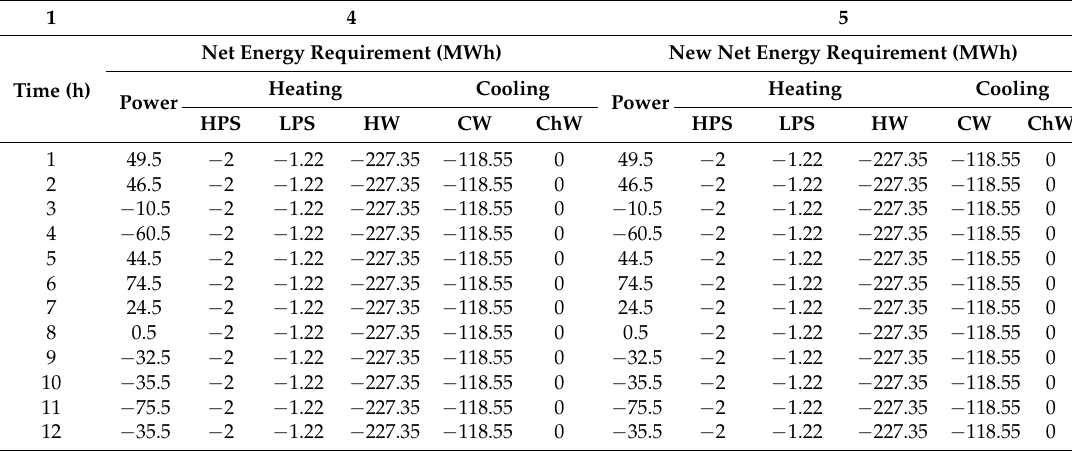
Table A3. TriGenSCA before iteration from time 1 to 12 h.